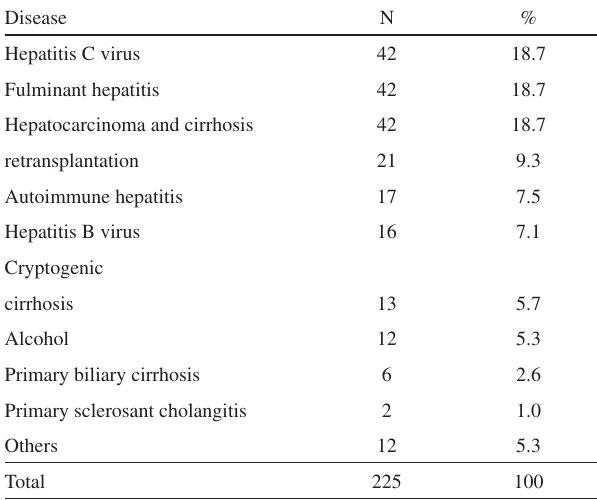
Table 3 - Indications for adult liver transplantation